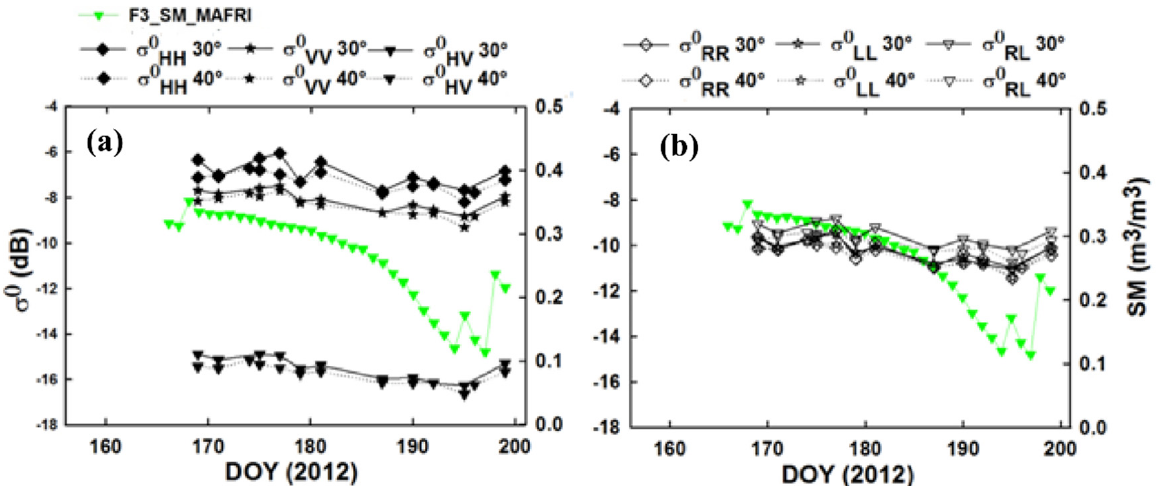
Figure 5. Temporal profiles of L-band ( a ) linear (HH, VV, and HV) and ( b ) circular (RR, LL, and RL) polarizations at θ = 30 and 40°, along with soil moisture measurements over F3. F3_SM_MAFRI is the soil moisture measured by the MAFRI station.